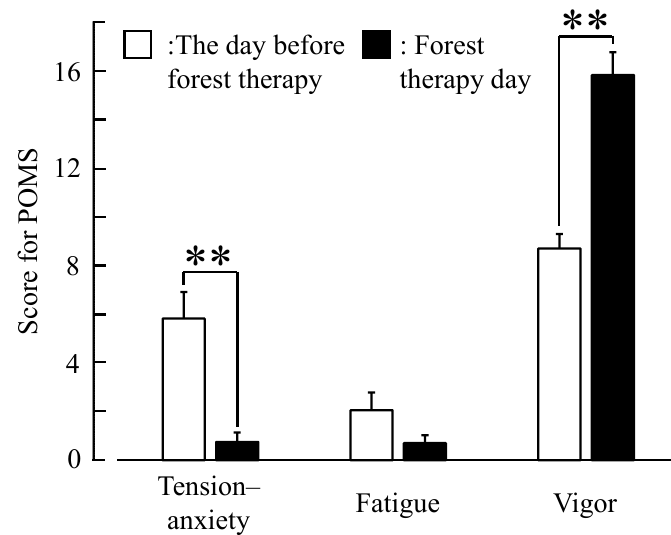
Figure 5. Lower negative and higher positive subjective Profile of Mood State (POMS) subscores after forest therapy than on the day before forest therapy. N = 17, mean ± standard error. ** p < 0.01, Wilcoxon signed-rank test.